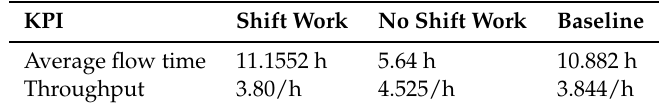
Table 2. Performance of the model when using shift work vs. not using shift work of nine resources.